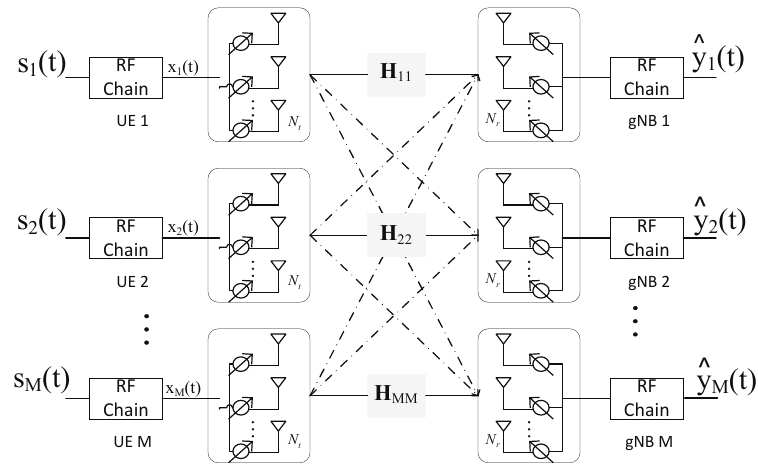
Figure 2. Signal transmission model with analog beamforming